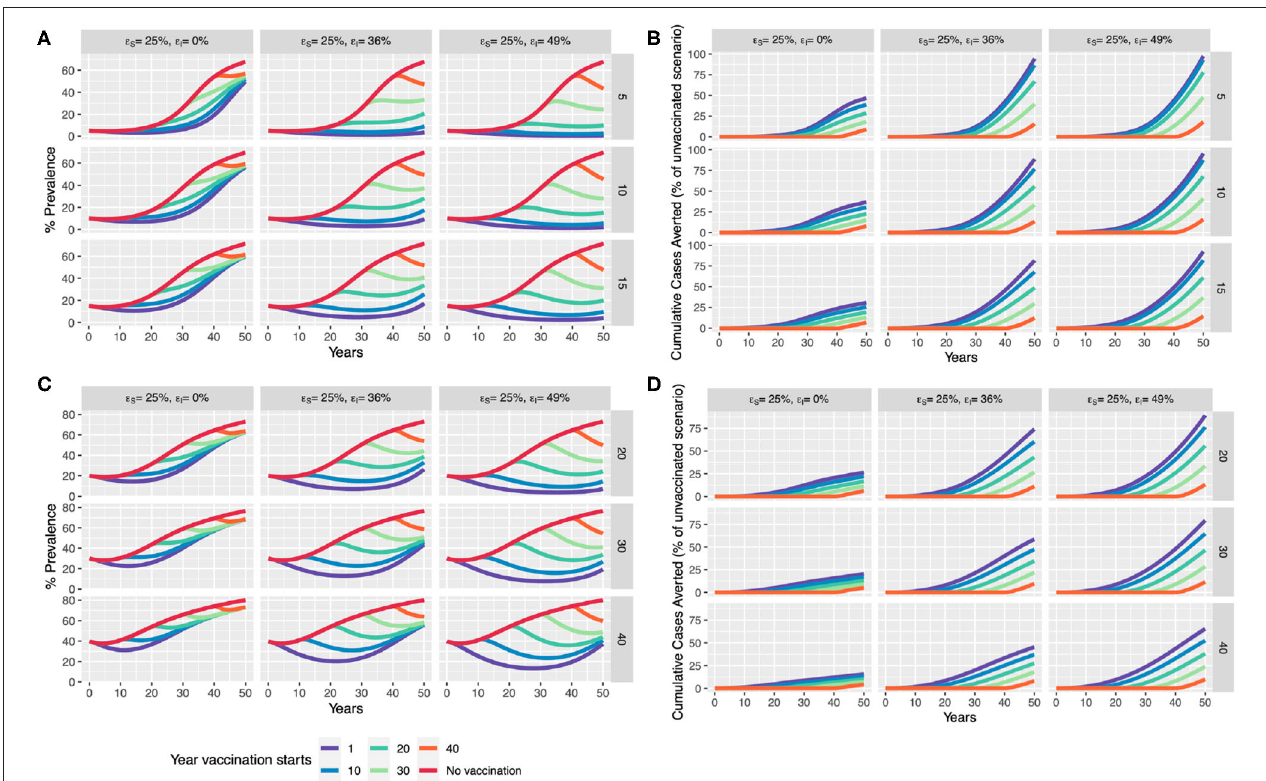
FIGURE 6 | Scenario analysis for impact of BCG vaccination in an expanding dairy herd. We compare a baseline “control” scenario (with no vaccination) to the introduction of whole-herd vaccination at 1, 10, 20, 30, and 40 years which only provides direct protection ( ε s of 25%), and one with an additional reduction in infectiousness of vaccinates ( ε I of 36 and 49%). We compare the effect of vaccination in terms of % prevalence and cumulative cases averted with assumed initial (A,B) moderate prevalence of 5, 10, and 15% (rows), and (C,D) high prevalence of 20, 30, and